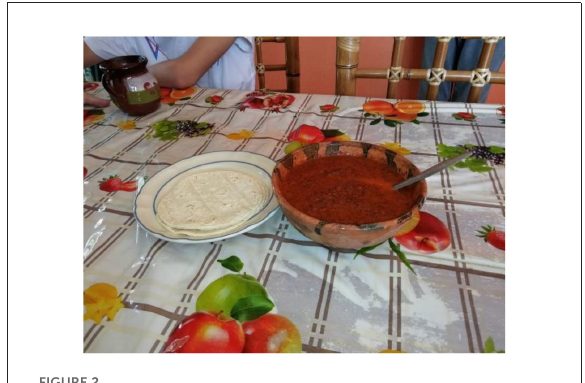
Traditional Chicatana ( Atta mexicana ) chili sauce. Source: Authors own picture.